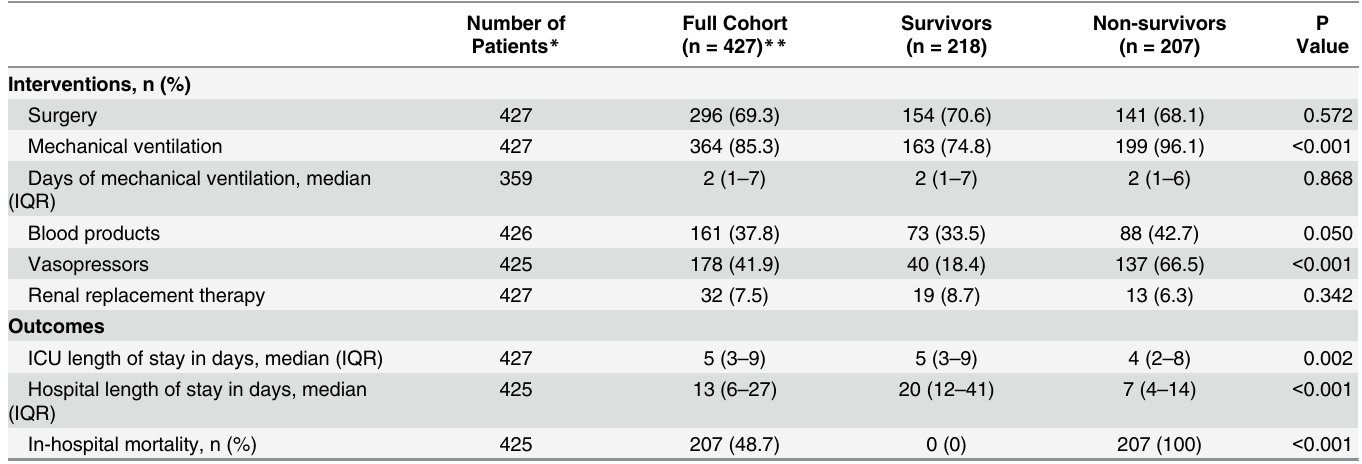
Table 3. ICU Interventions and Outcomes.